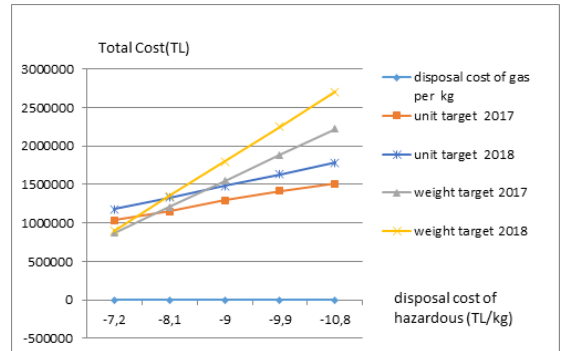
Figure 5. Sensitivity analysis of disposal cost of refrigerant